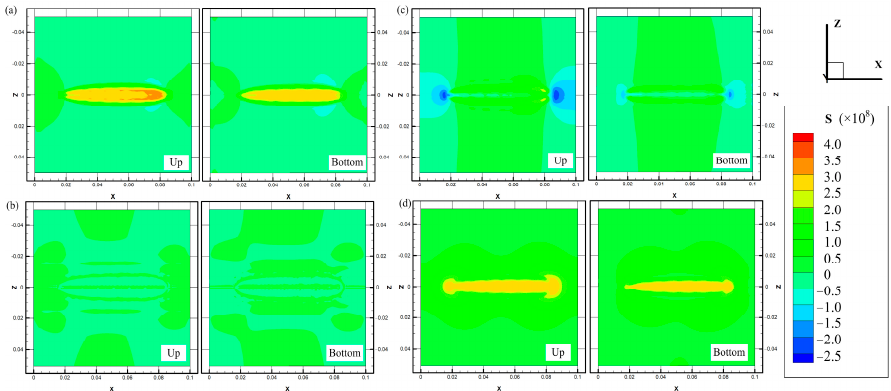
Figure 11. Residual stress of the whole weld sample: ( a ) Sx, ( b ) Sy, ( c ) Sz, and ( d )